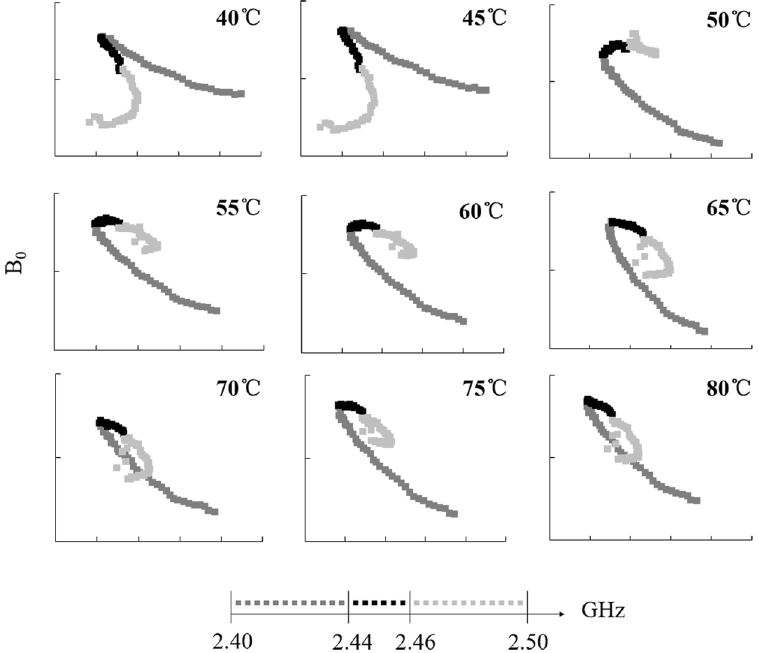
Figure 7. Change curve of starch–water mixtures B 0 ( = ε″ f B /